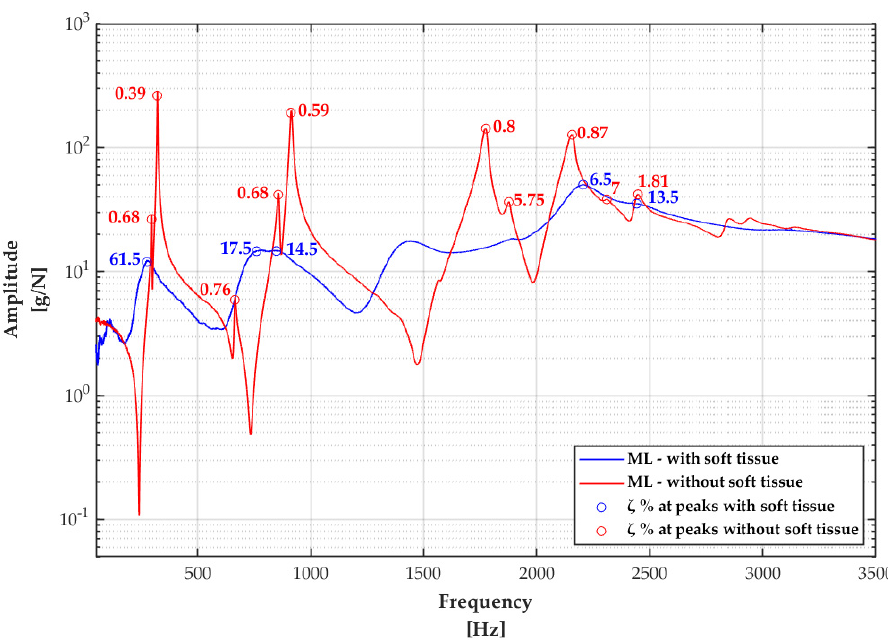
Figure 11. Influence of soft tissue on FRF and damping factors at most prominent peaks for the ML measurements.